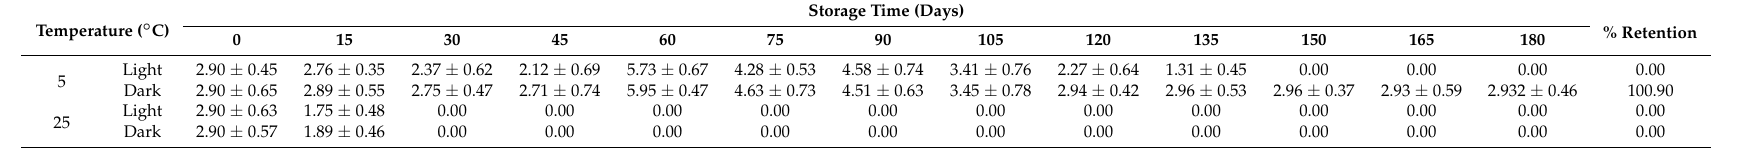
Table 5. Stability profile of isoeugenol under different storage temperatures and light for 180 days.